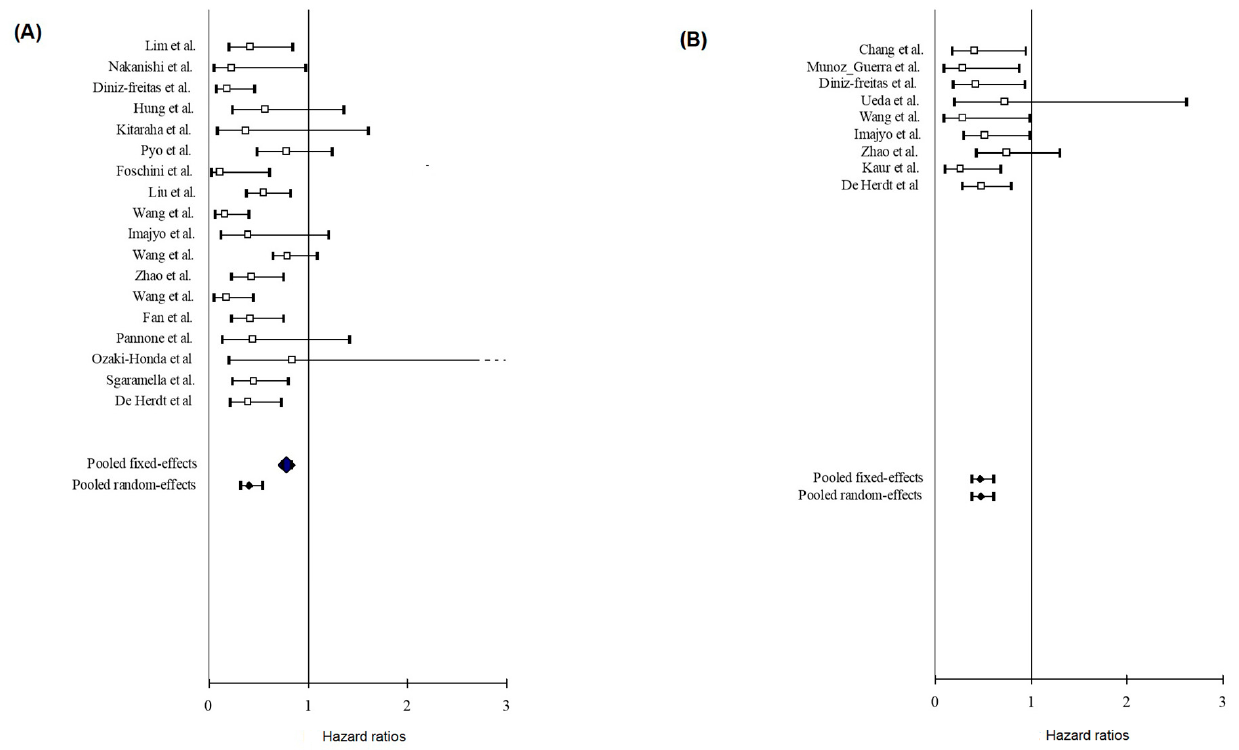
Figure 3. ( A ) Forest plots of overall survival and ( B ) disease-free survival. Horizontal axis represents Hazard